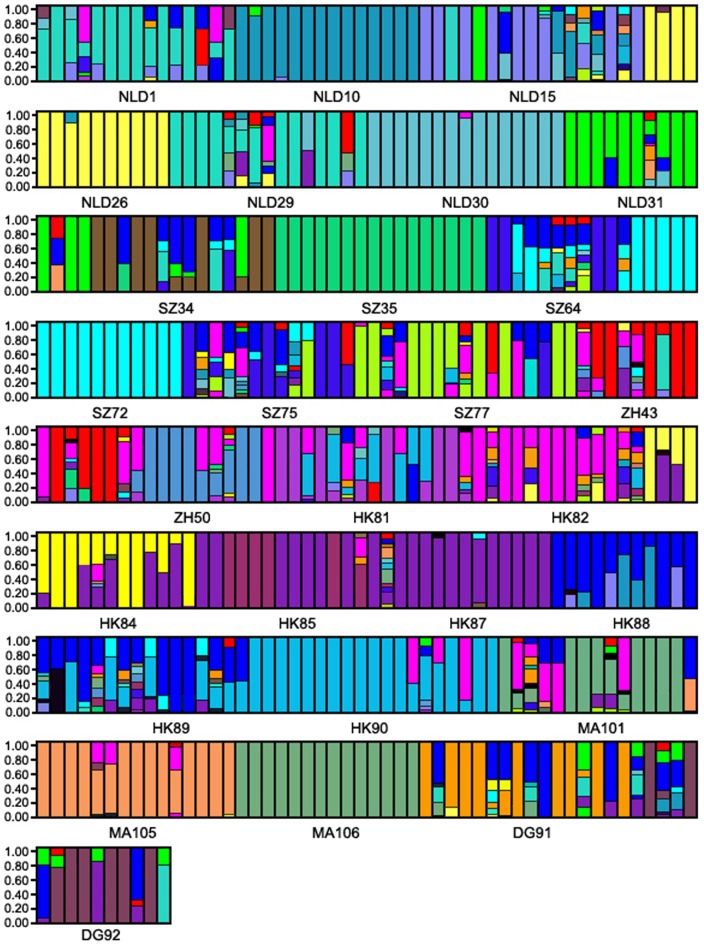
Bayesian assignment proportions for K = 28 clusters determined in STRUCTURE 2.3.3.Each vertical bar represents one individual.